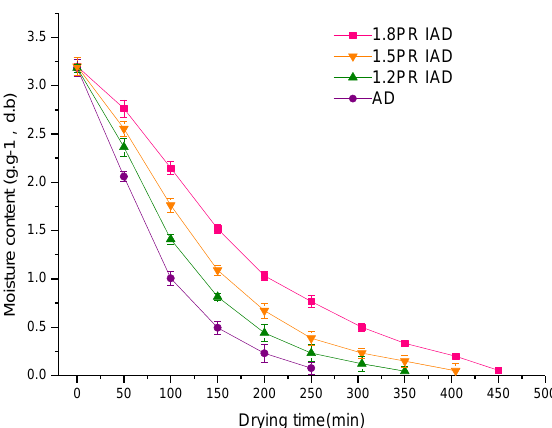
Figure 2. Water dynamics of litchi dried by drying schemes with di ff erent pulse ratios. Note: AD is air drying, IAD is intermittent air drying, PR is pulse ratio [(drying time + interval time) / drying time] in one cycle, average value ± standard deviation, d.b. is dried basis.